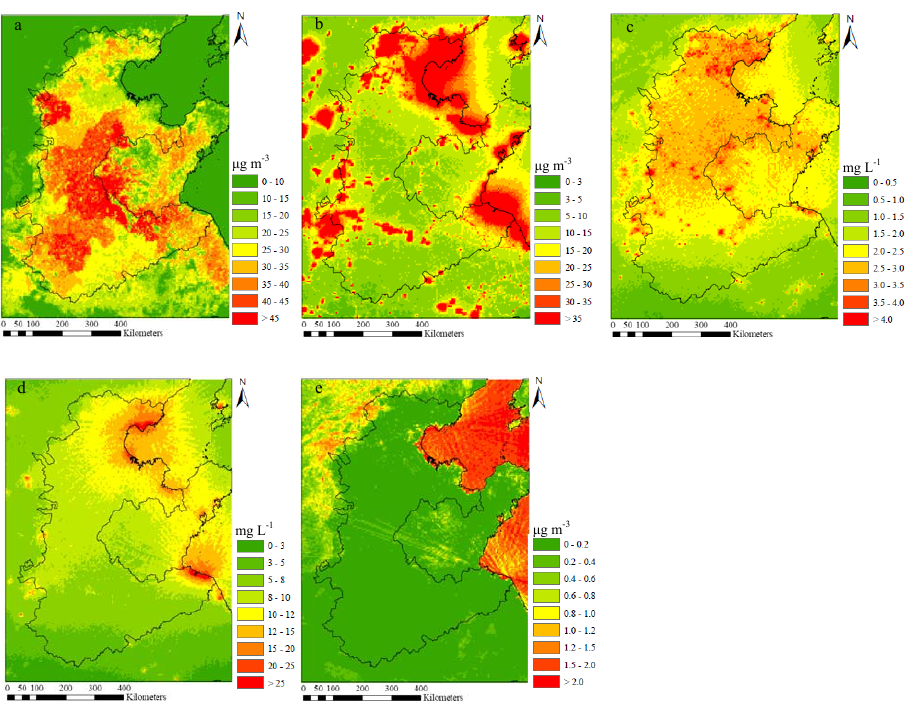
Figure 6. Modeled concentrations of N-containing pollutants in the NCP in 2008 at 5×5 km 2 resolution (a. NH 3 ; b. NO x ; c. NH 4+ ; d. Fig. 6. Modeled concentrations of N-containing pollutants in the NCP in 2008 at 5 × 5km 2 resolution (a. NH 3 ; b. NO x ; c. NH + e. HNO 3 ) . NO 3- ; e. HNO 3 ).